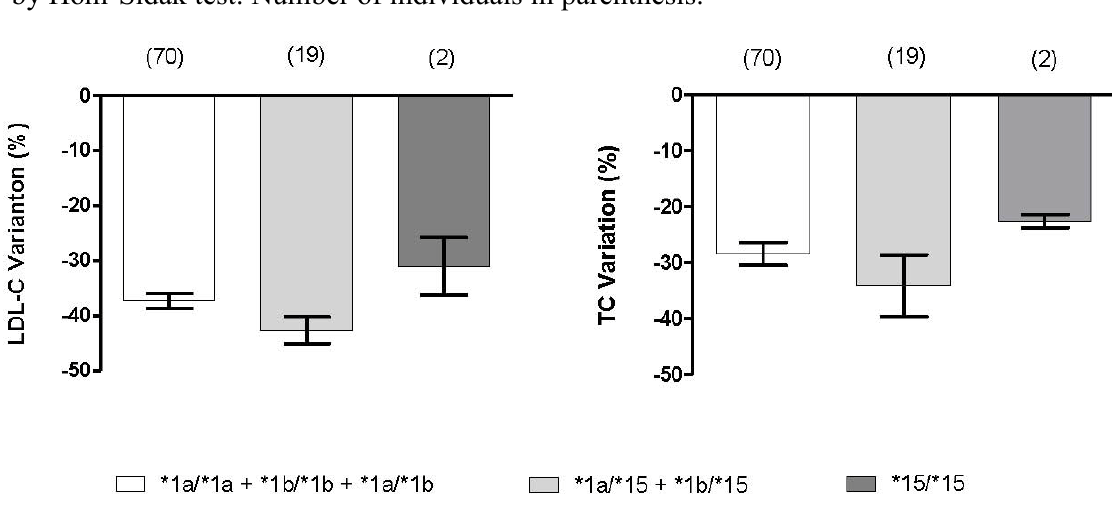
Figure 1. Influence of the SLCO1B1 *15 variant on reduction of total (TC) and low-density lipoprotein (LDL-C) cholesterol in response to atorvastatin (10 mg/day/4 weeks). P > 0.05, as compared by One-Way Analysis of Variance followed by Hom-Sidak test. Number of individuals in parenthesis.